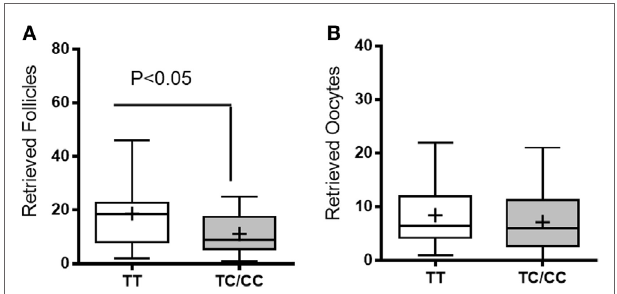
FigUre 1 | Follicles (a) and retrieved oocytes (B) . White bars represent women carrying the TT genotype, whereas gray bars represent women carrying the TC/CC genotypes. Unpaired t -test. The data are presented as the mean ± min and max.